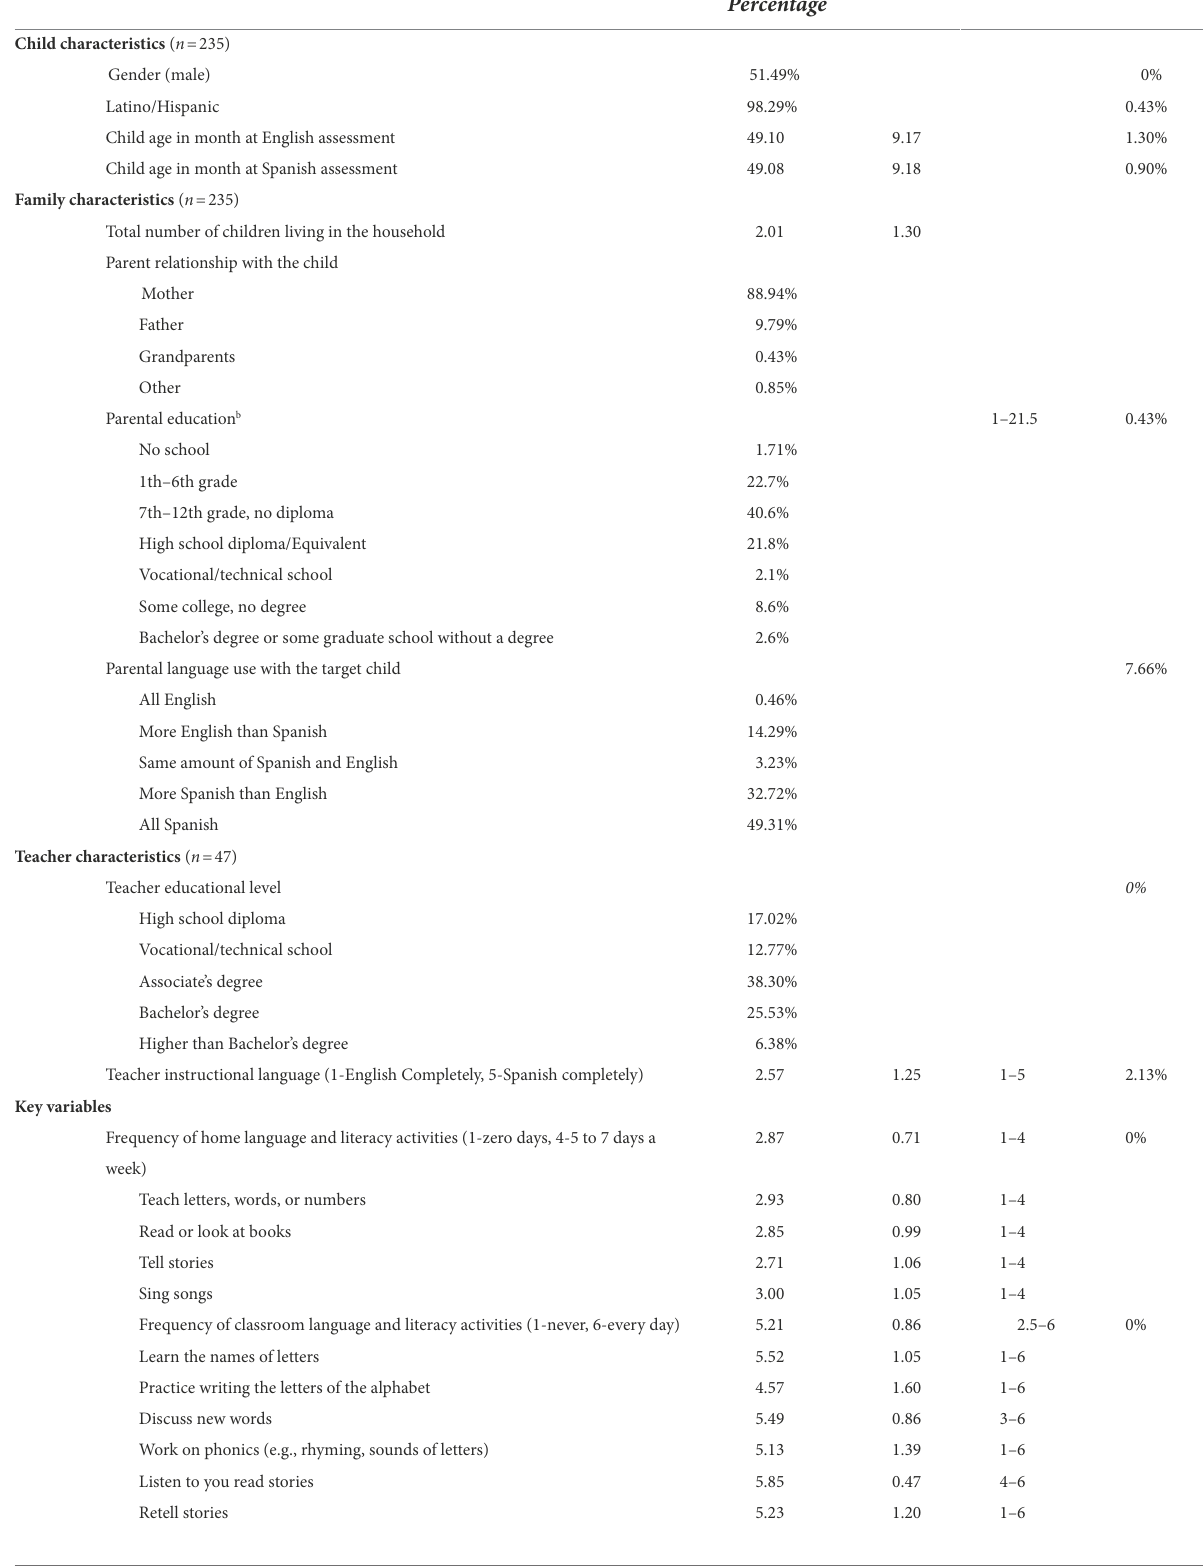
Mean or SD Range a Missing Percentage